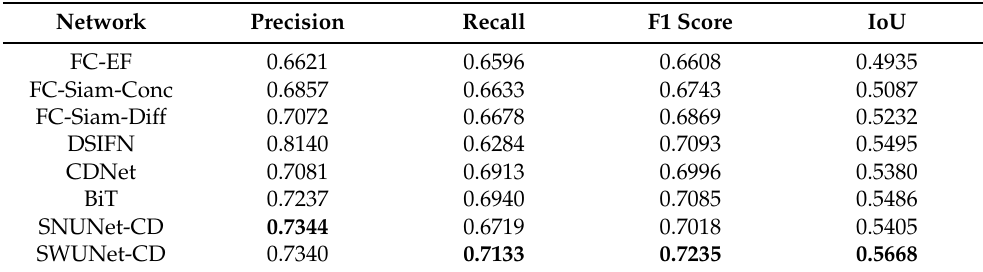
Table 4. Comparison with other